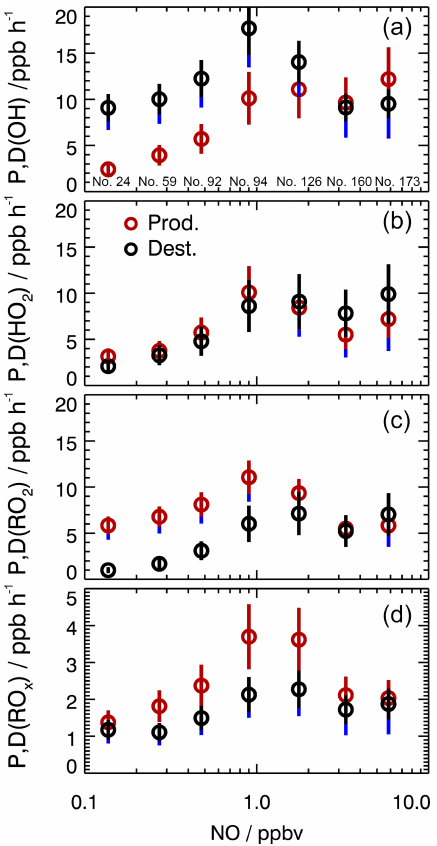
Figure 4. Experimental production and destruction rates for OH, HO 2 , and RO 2 as a function of NO. The circles represent median values for NO intervals of ln ( NO )/ ppbv = 0 . 57. Data are restricted to daytime conditions ( j( O 1 D ) > 0 . 1 × 10 − 5 s − 1 ). The number (no.) of data points included in each NO bin is given in (a) . Ver- tical error bars (red and black) denote the 1 σ uncertainties due to experimental errors of the measured quantities (Table S1) and the reaction rate coefficients. Vertical blue bars denote the maximum possible bias from a potential OH